Question: Which kind of chart has been used to present this data?
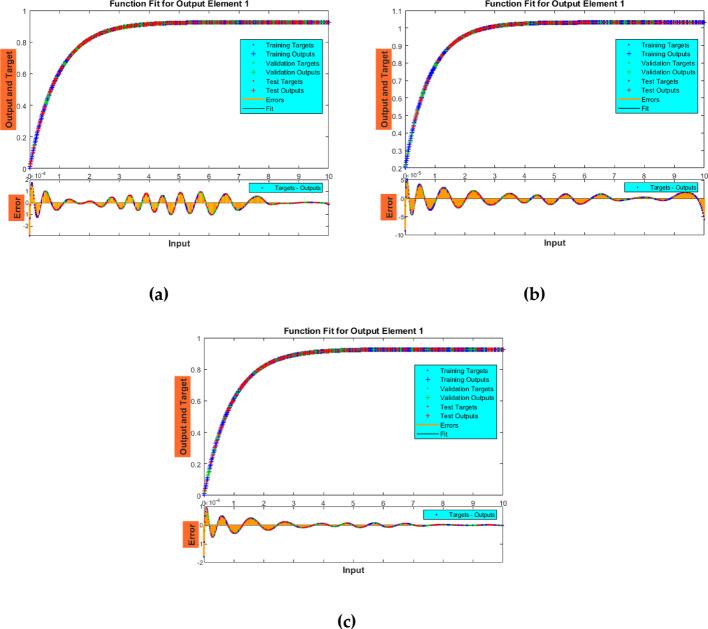
Answer: line